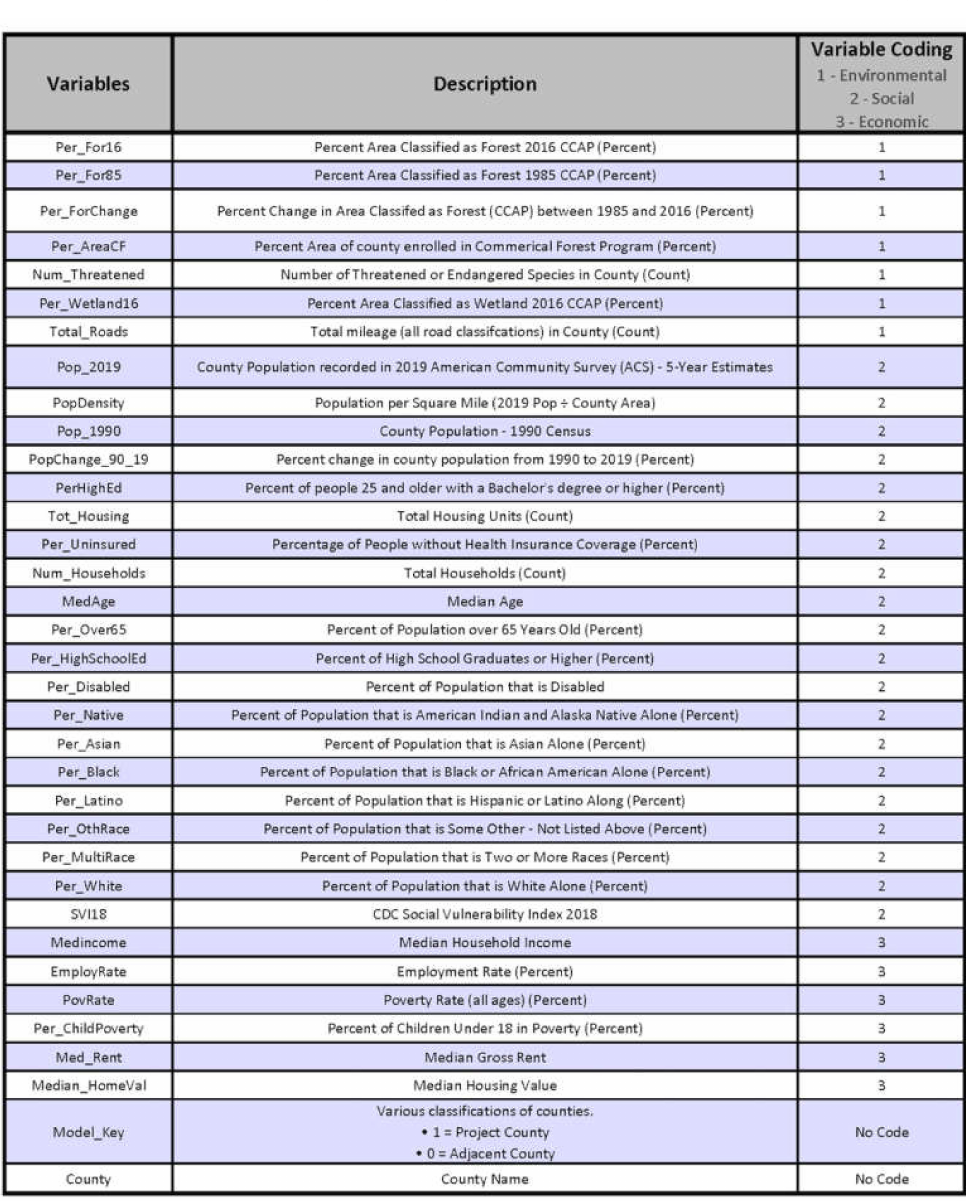
Figure 4. Environmental, social/demographic, and economic variables involved in the development of woody biomass facil- ities in Michigan. Data from the 2019 American Community Survey and 2016 Coastal Change Analysis Program